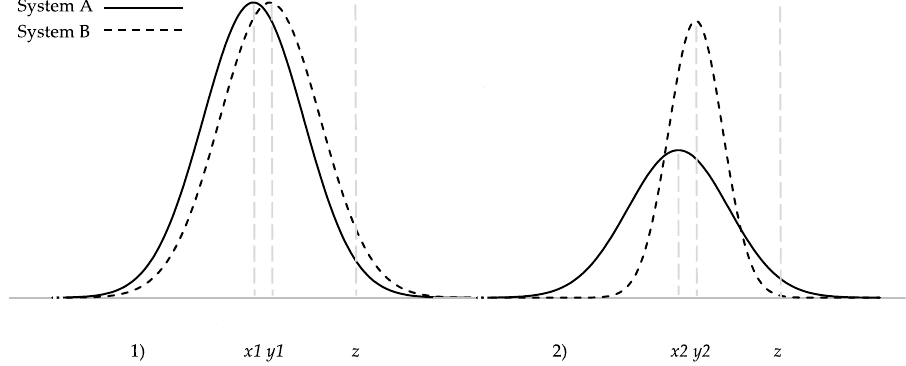
Figure 1. Comparison between deterministic and stochastic values in different